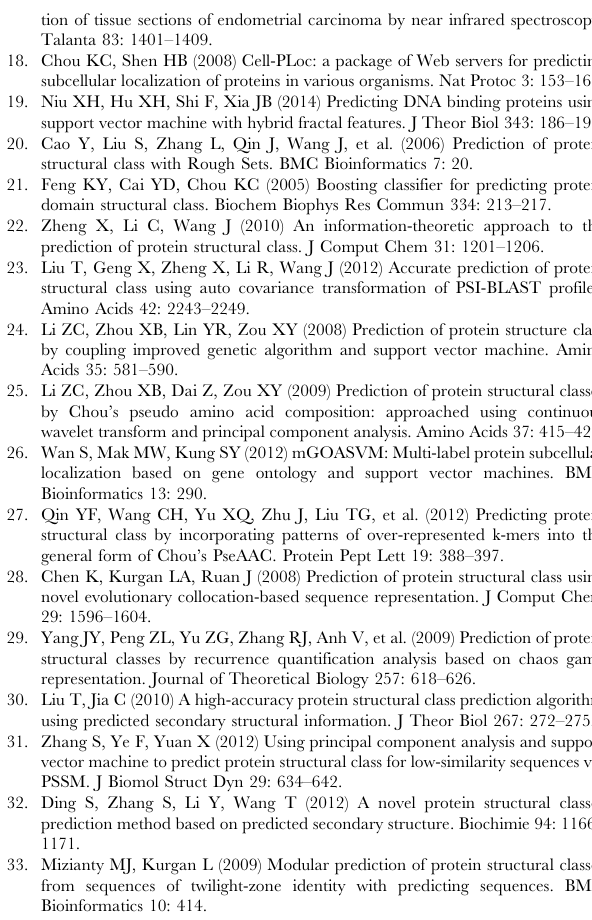
Figure S1 The ROC curves for D640 dataset.